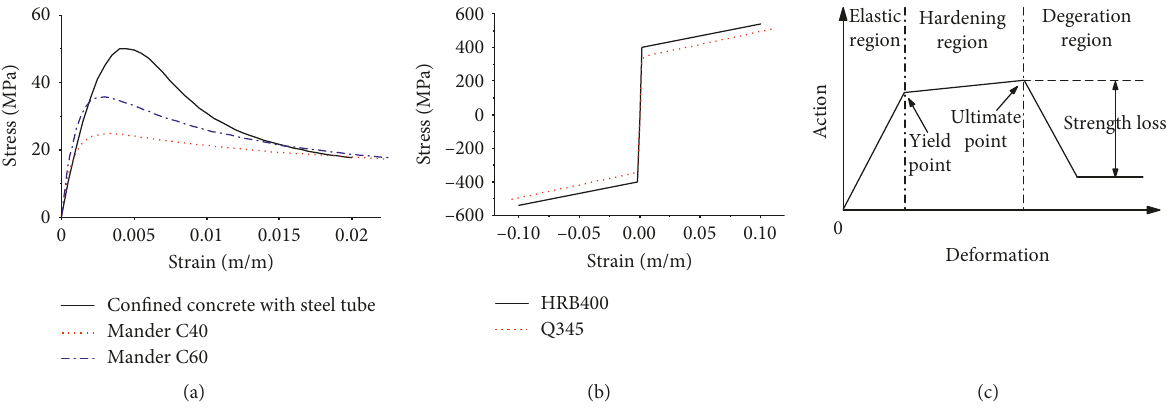
Figure 4: Constitutive curve for concrete, steel, and plastic hinge model. (a) Concrete. (b) Steel. (c) Plastic hinge